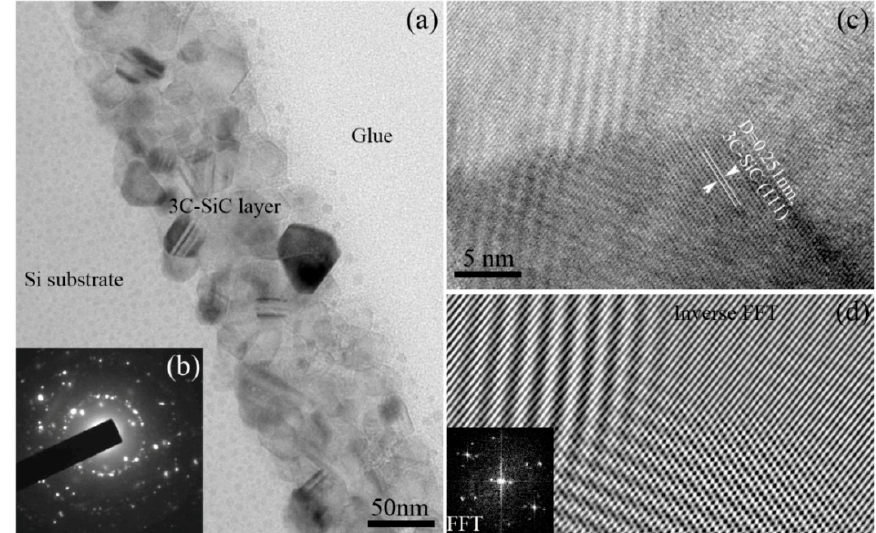
Figure 4. Bright field transmission electron microscopy (TEM) images and selected area electron diffraction (SAED) pattern of the annealed 3C-SiC thin film prepared from the mixture gases of SiH 4 :CH 4 = 2:10, ( a ) The microstructure of 3C-SiC film; ( b ) SAED pattern of deposited film; ( c ) High-resolution TEM (HRTEM) image showing the grain boundaries; ( d ) Inverse FFT image of the HRTEM image of ( c ).